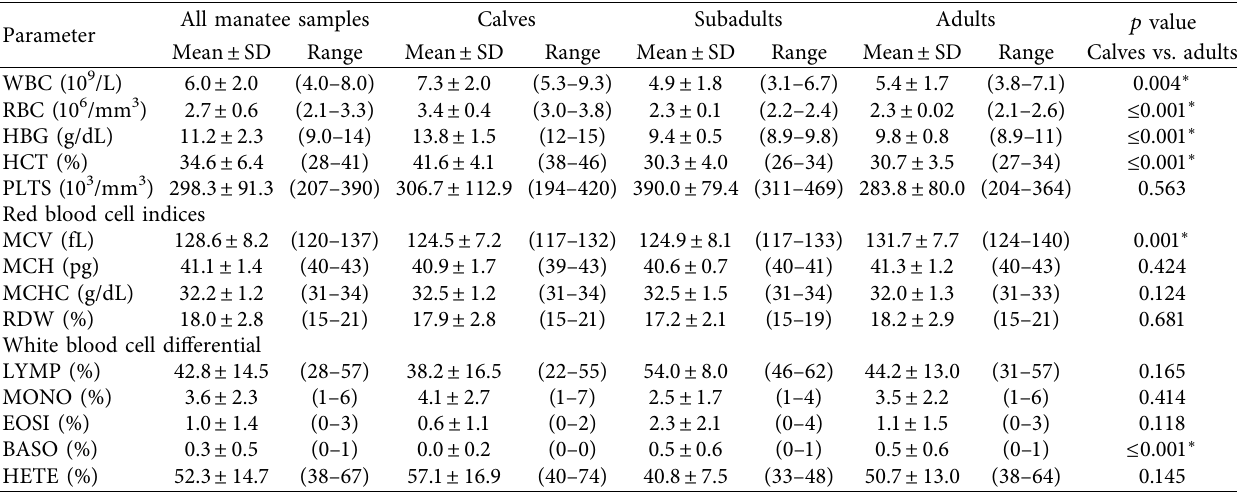
Table 2: Mean and standard deviation hematology values for Antillean manatees from Puerto Rico for all age classes (calves, subadults, and adults; n � 70): calves only, n � 23; subadults only, n � 6; and adults only, n � 41, with ± 1 standard deviation ranges in parentheses. Significant differences using p values between calves and adults are indicated with an asterisk ( ∗ ).